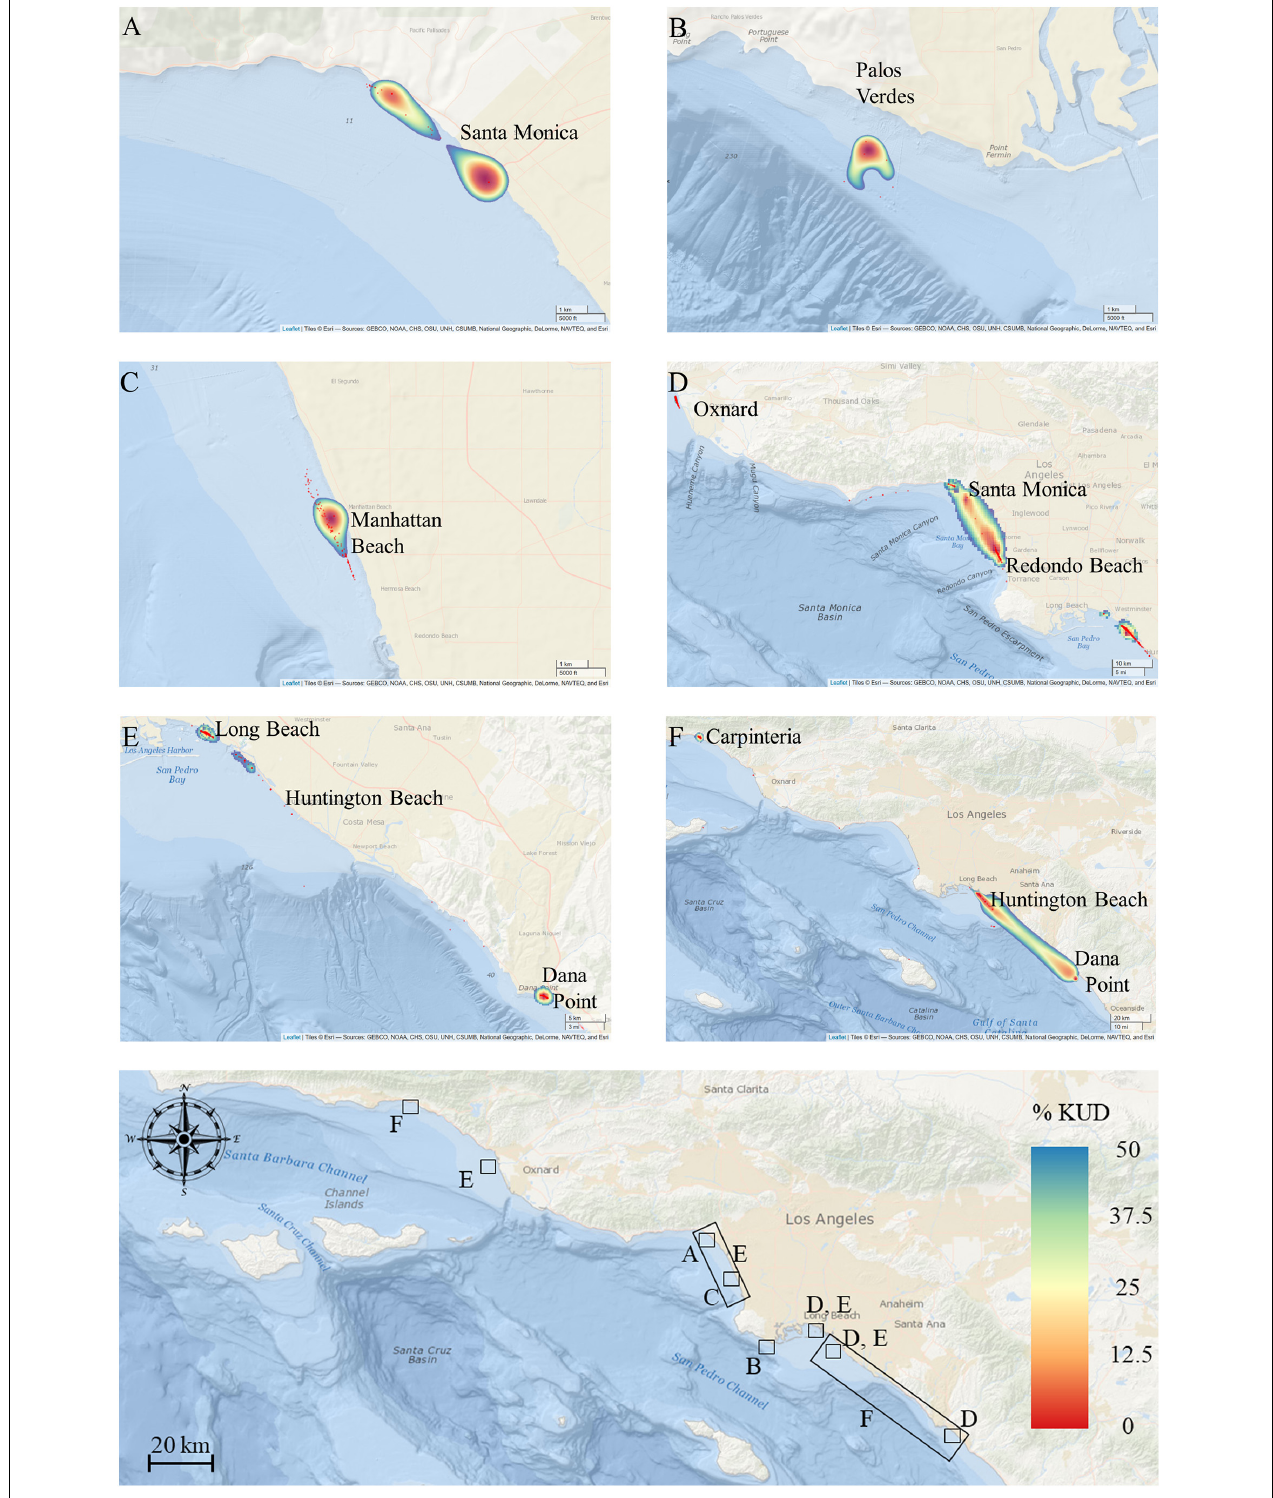
FIGURE 7 | Activity space estimates for animals, overlaid for each year [ (A) 2010, (B) 2011, (C) 2013, (D) 2015, (E) 2017, (F) 2018]. Base map shows the locations of BBKUD plots for each panel with reference to the southern California coastline and wider study area. Geographic locations of core activity in each year reflect areas of peak shark density and